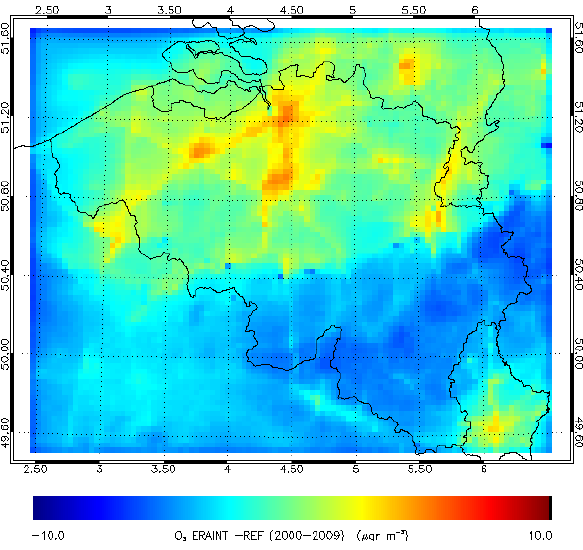
Figure 8. Mean difference map between the ERAINT and the Ref- erence scenario for the present day